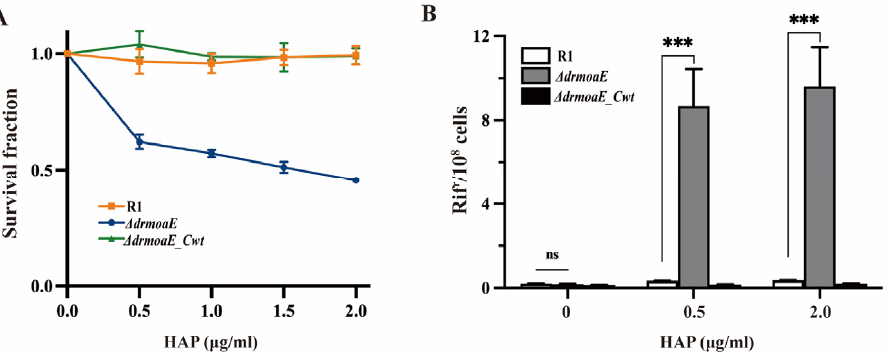
Figure 6. Survival rate ( A ) and mutation rate ( B ) of the wild-type strain (R1), the mutant strain ( ∆ drmoaE ), and the complementary strain ( ∆ drmoaE_Cwt ) exposed to HAP. The survival rate was determined after a 2 h exposure to HAP in the TGY medium. The mutation rate was measured after overnight exposure to HAP in the TGY medium. Each value represents the mean of three assays (mean ± SD). “ns” means not significant. *** p < 0.001.